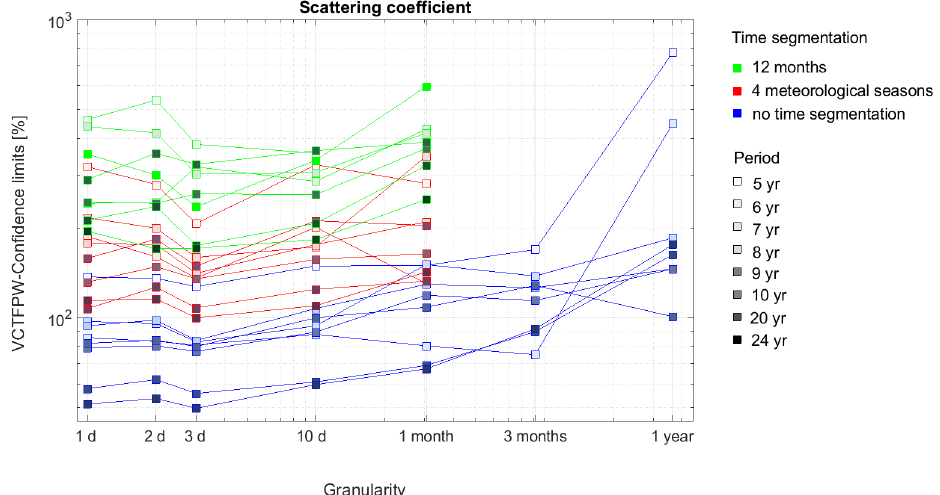
Figure 9. Confidence limits of VCTFPW as a function of the time granularity for various periods of the aerosol scattering coefficient time series. Blue represents no consideration of seasonalities; red represents time segmentation into four meteorological seasons and green into 12 months. The color shading corresponds to the length of the period from 5 years (lightest) to 24 years